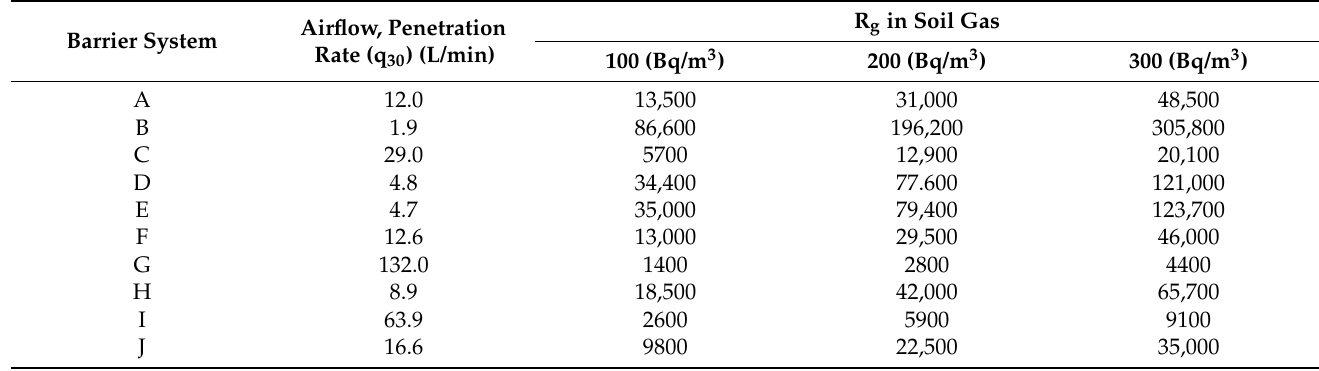
Table 3. Maximum soil gas penetration to reach an indoor radon concentration of 100, 200 and 300 Bq/m 3 for System A to J barriers. The air-change rate was 0.5 h − 1 , and the initial radon contribu- tion from indoor materials (R im ) was 40 Bq/m 3 . The airflow penetration rate (q 30 ) defines how well a barrier prevents soil gas